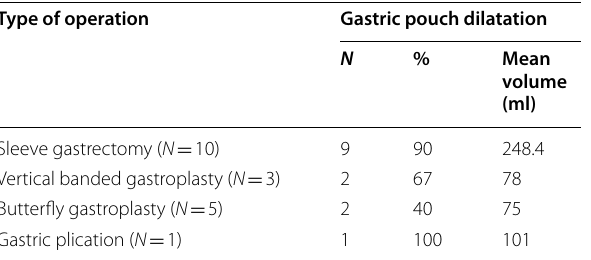
Table 2 Degree of gastric pouch dilatation in the studied bariatric surgeries Type of